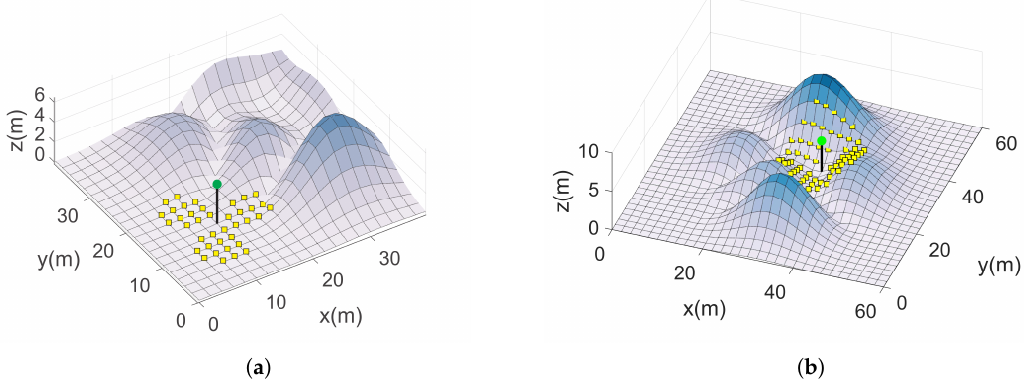
Figure 10. O-AUV sensing model. ( a ) the coverage area of the O-AUV sensing model on the plane area; ( b ) the coverage area of the O-AUV sensing model on the complex